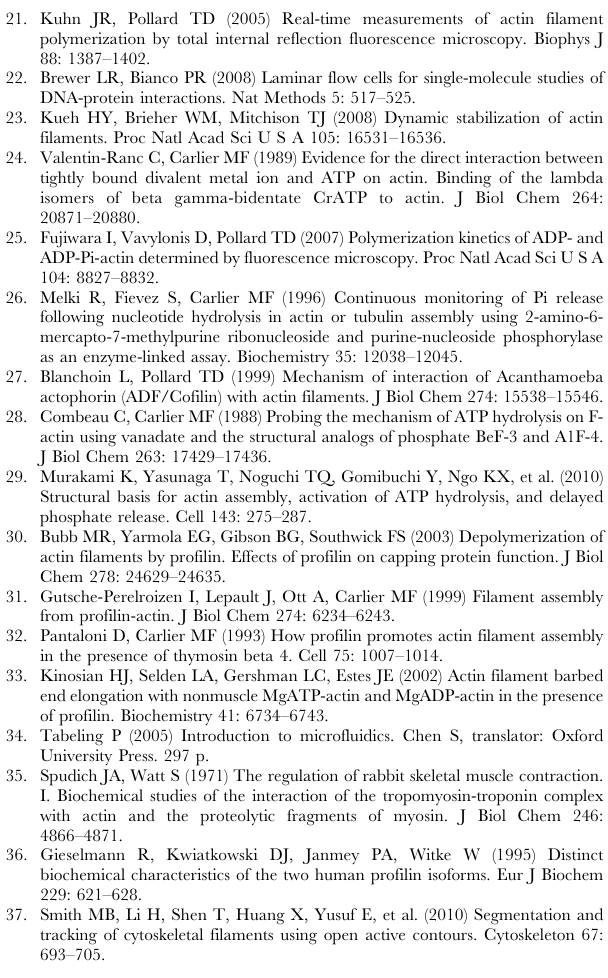
merizaton of actin filaments, (III) analysis of length-versus-time data for depolymerizing filaments, (IV) stochastic simulations. (PDF) Video S1 Individual actin filament, elongated and subsequently depolymerized in a microfluidic flow. The filament is elongated for 6 min, from an initial length of 2.4 m m to a final length of 14.3 m m (30 s between images, acquired in TIRF microscopy). It is depolymerized by switching to buffer with no actin, and depolymerization lasts 12 min (20 s between images, acquired in epifluorescence microscopy). Liquid is flowing from left to right. Contrast was enhanced as described in the text.